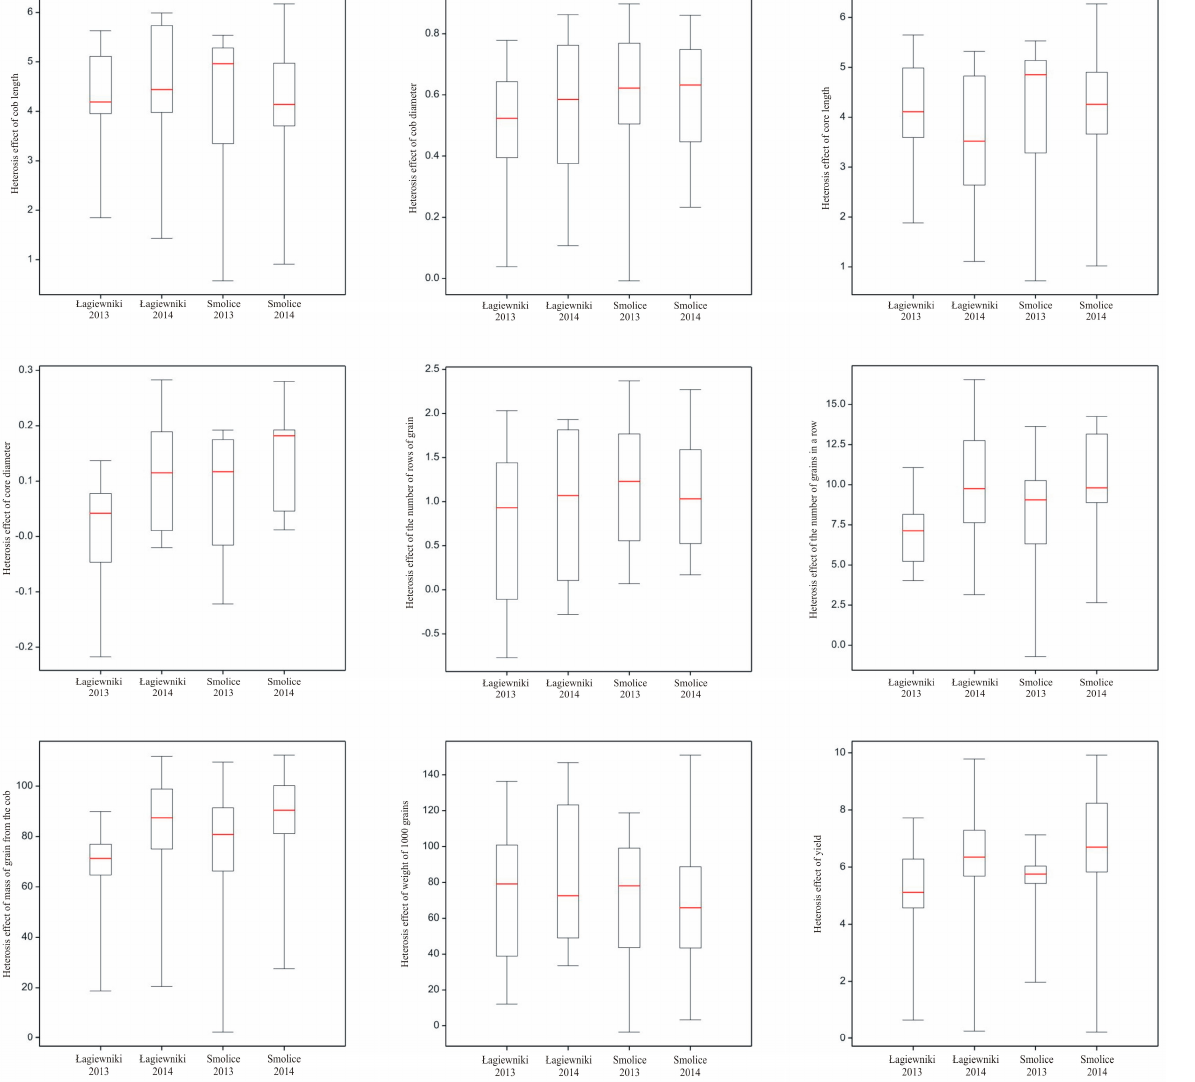
Figure 2. Box-and-whisker diagrams of the values of heterosis e ff ects of nine quantitative traits; classi fi ed by the studied environments.